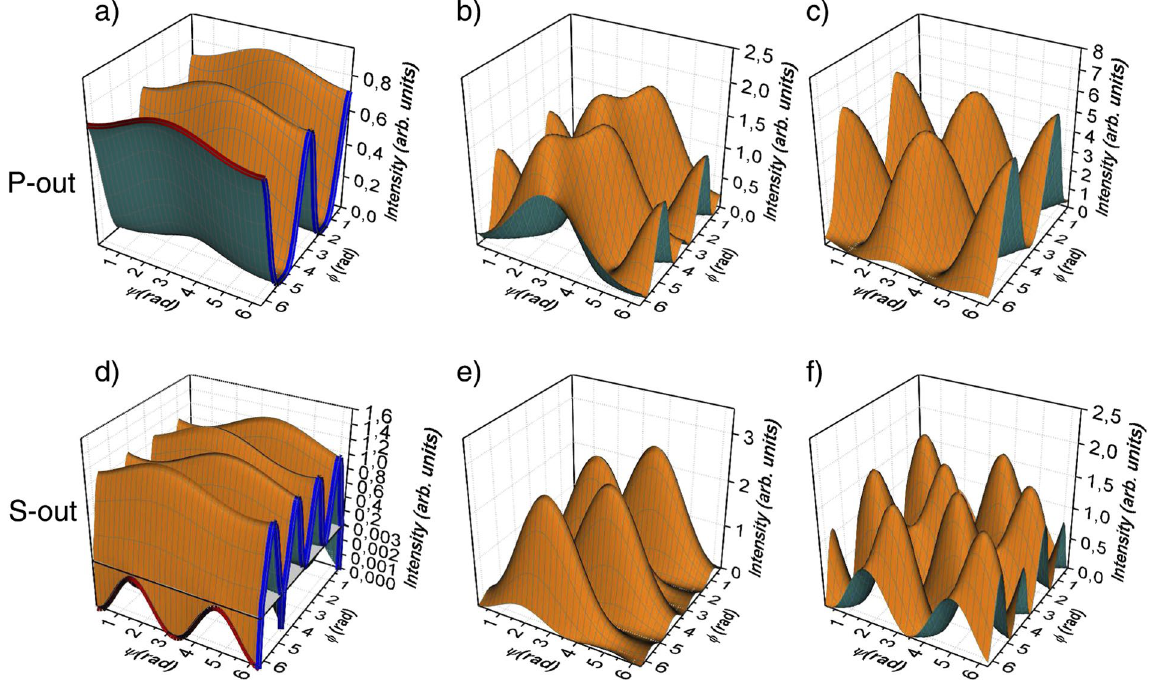
Figure 4. Polarization dependences obtained within the suggested model for different γ : ( a , d ) γ = 0.05; ( b , e ) γ = 0.5; ( c , f ) γ = 1. Blue and red lines on ( a and d ) represent the linear plots of fitting curve from Fig. 1c and